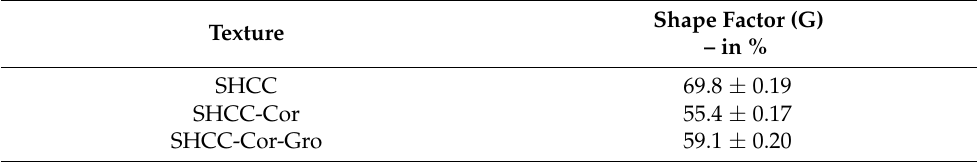
Table 5. Shape factor of SHCC, modified SHCC-Cor, and SHCC-Cor-Gro.